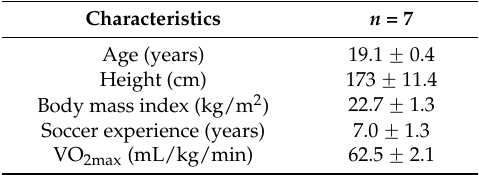
Table 1. Baseline descriptive characteristics of